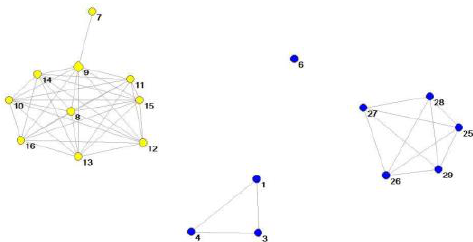
Fig.9. The deconstruction of Marc's network, stage